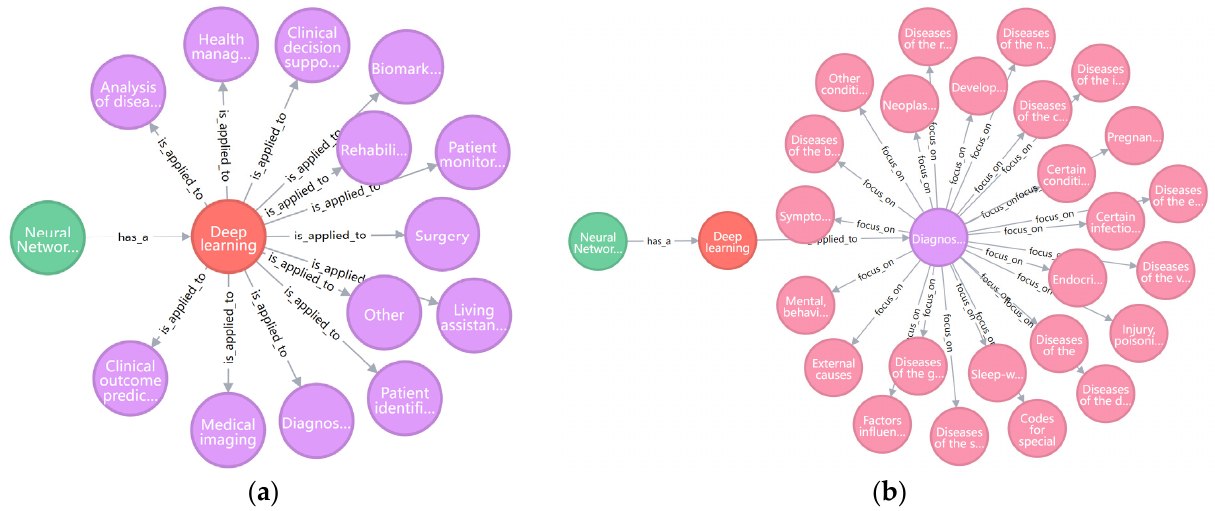
Figure 3. Part of the AI technology application graph. ( a ) The left figure shows the application of DL technology in different healthcare scenarios. ( b ) The right figure shows the situation of DL technology application in the diagnosis and screening field of various condition areas.